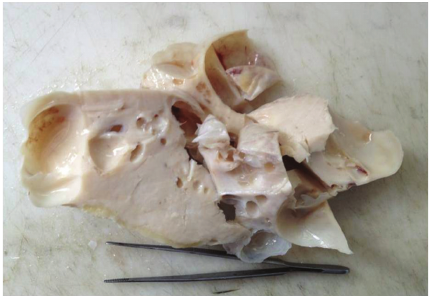
Figure 3: Macroscopic appearance of the tumor: mass measuring 25/22 cm with a smooth and translucent external appearance. On section, the mass is midcystic and